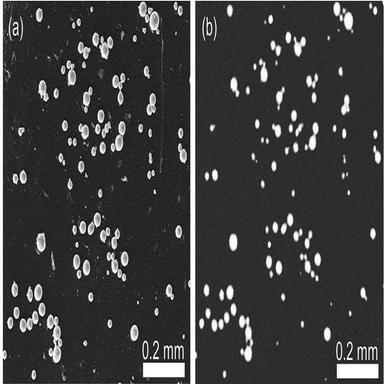
Example of SEM image of powder (a) and CT image of the same powder obtained by superimposing the stacked CT cross-sections and keeping the maximum grey value for each pixel in the final image (b).